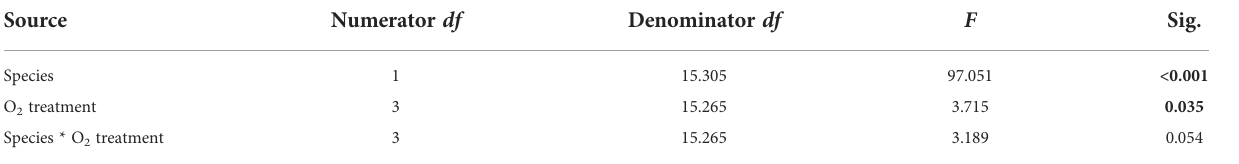
TABLE 4 Summary of results for LMMs comparing Symbiodiniaceae cell densities between treatments for both species.